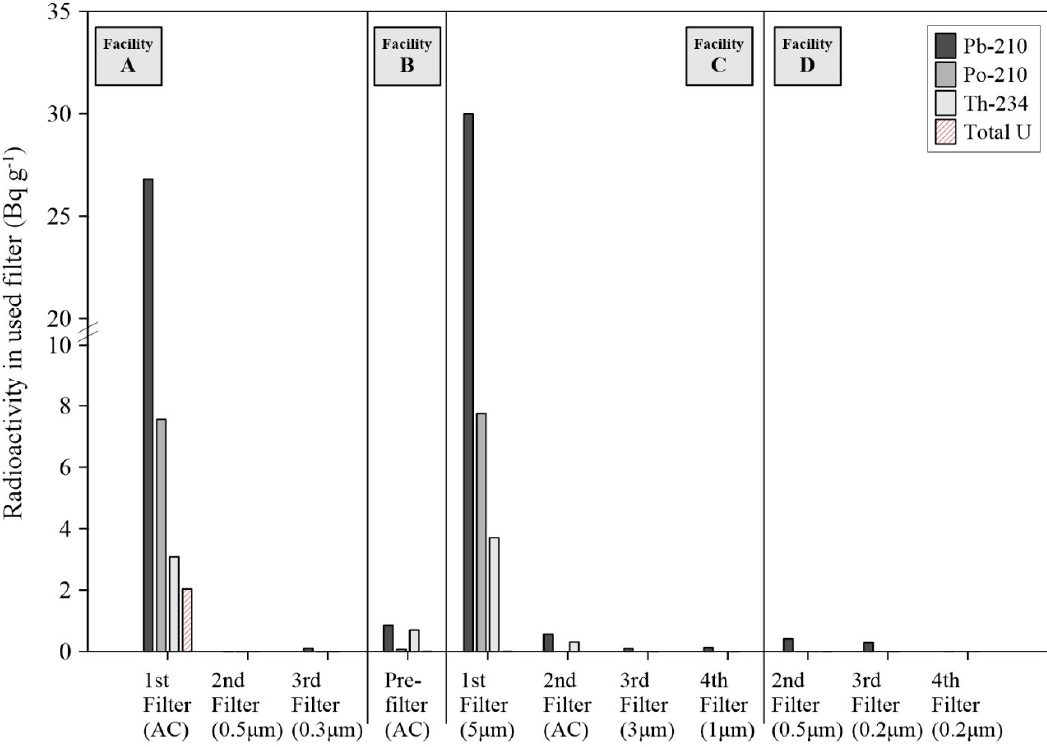
Figure 4. The measured radioactivity and concentrations of remaining radionuclides in the used filters.